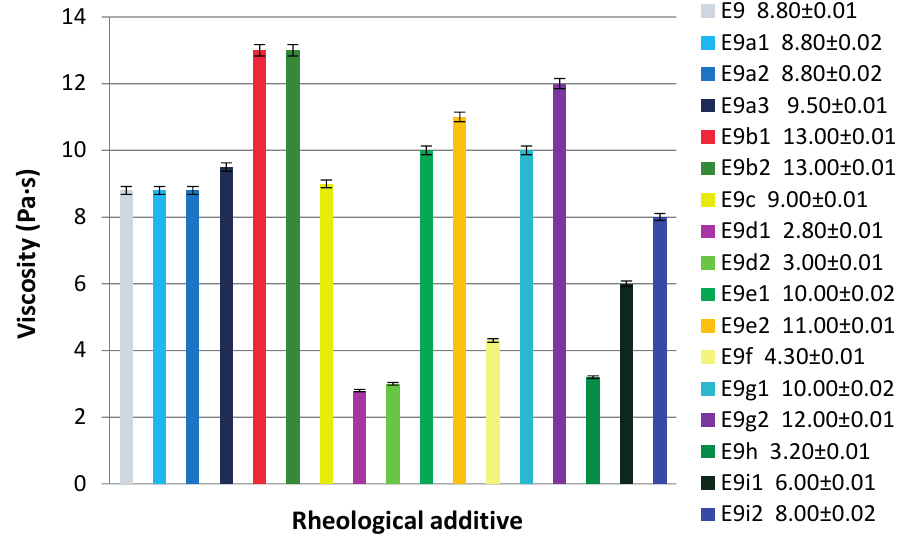
Figure 7. Effect of rheological additive on the viscosity of basic emulsion (E9): E9a1 : Carbomer 0.1%; E9a2 : Carbomer 0.15%; E9a3 : Carbomer 0.20%; E9b1 : Acrylates/C 10–30 Alkyl Acrylate Crosspolymer 0.10%; E9b2: Acrylates/C 10–30 Alkyl Acrylate Crosspolymer 0.15%; E9c : Sodium Polyacrylate; E9d1 : Xanthan gum 0.30%; E9d2 : Xanthan gum 0.50%; E9e1 : Dehydroxanthan gum 0.30%; E9e2 : Dehydroxanthan gum 0.50%; E9f : Hydroxyethylcellulose; E9g1 : Hydroxypropylstarch phosphate 0.50%; E9g2 : Hydroxypropylstarch phosphate 1.00%; E9h : Hydroxypropyl guar; E9i1 :